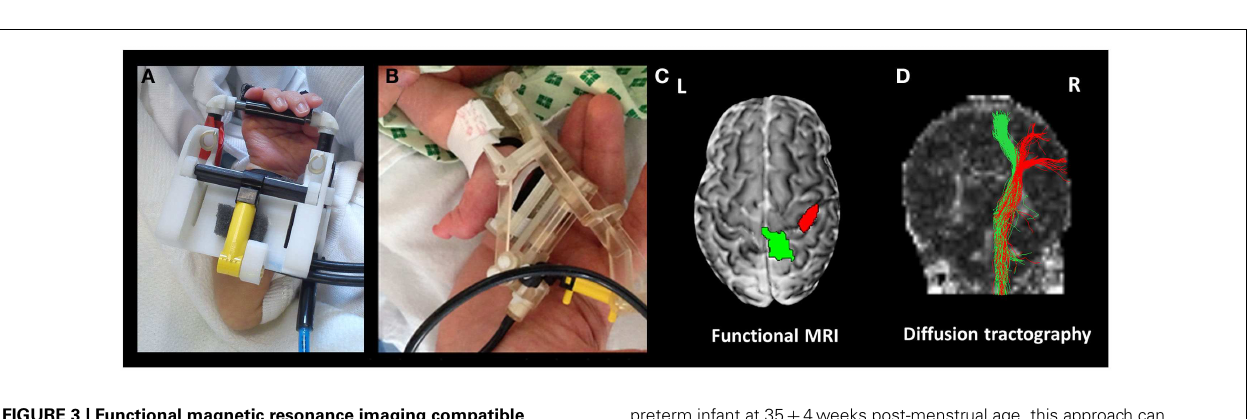
FIGURE 3 | Functional magnetic resonance imaging compatible devices can be used to precisely map functional activity and axonal pathways .The devices are fitted to the subjects’ limbs prior to scanning, and can provide a safe and reproducible pattern of stimulation, which is fully automated and synchronized with fMRI data acquisition. Shown are devices fitted to the wrist (A) and ankle (B) . In a